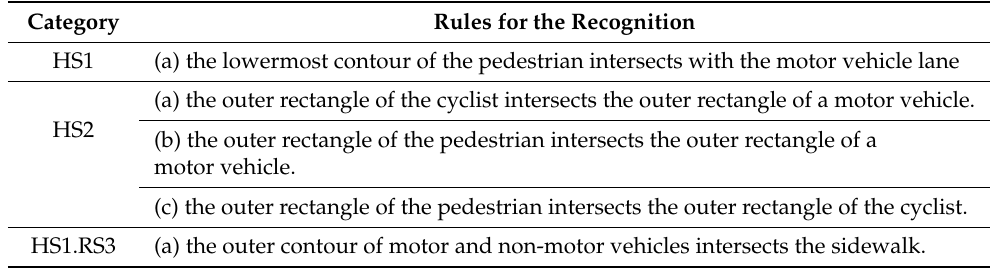
Table 4. The screening criterion for each type of suspected scenarios.